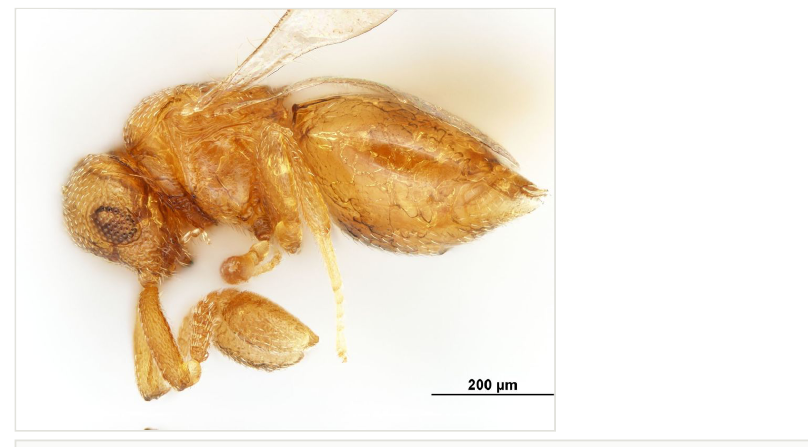
Figure 2. Bright fi eld image showing the lateral habitus of Pteroceraphron mirabilipennis Dessart